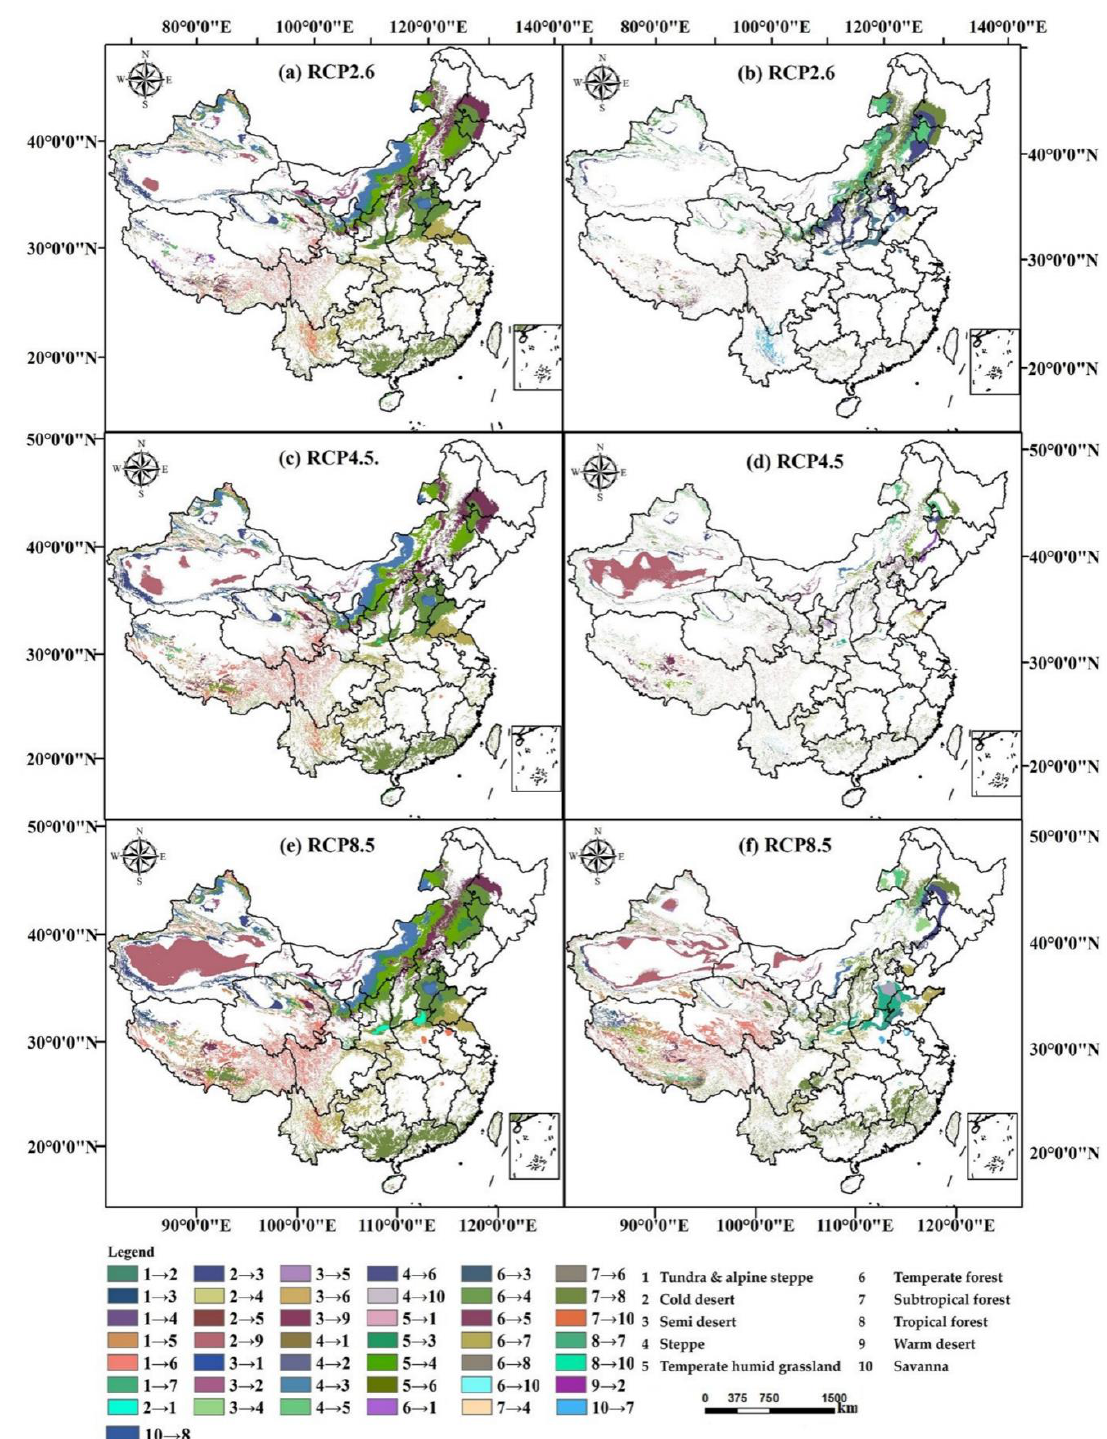
Figure 16. Spatial distributions of successions among PNV super-classes from 1970–2000 to 2050s ( left ) and from the 2050s to 2080s ( right ) under RCP2.6 ( a , b ), RCP4.5 ( c , d ), and RCP8.5 ( e , f ).